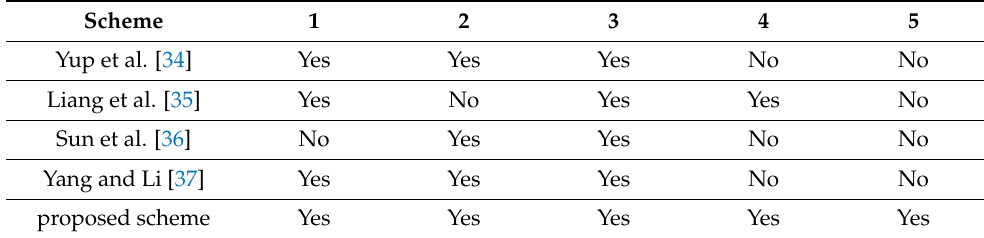
Table 6. The function comparison with other